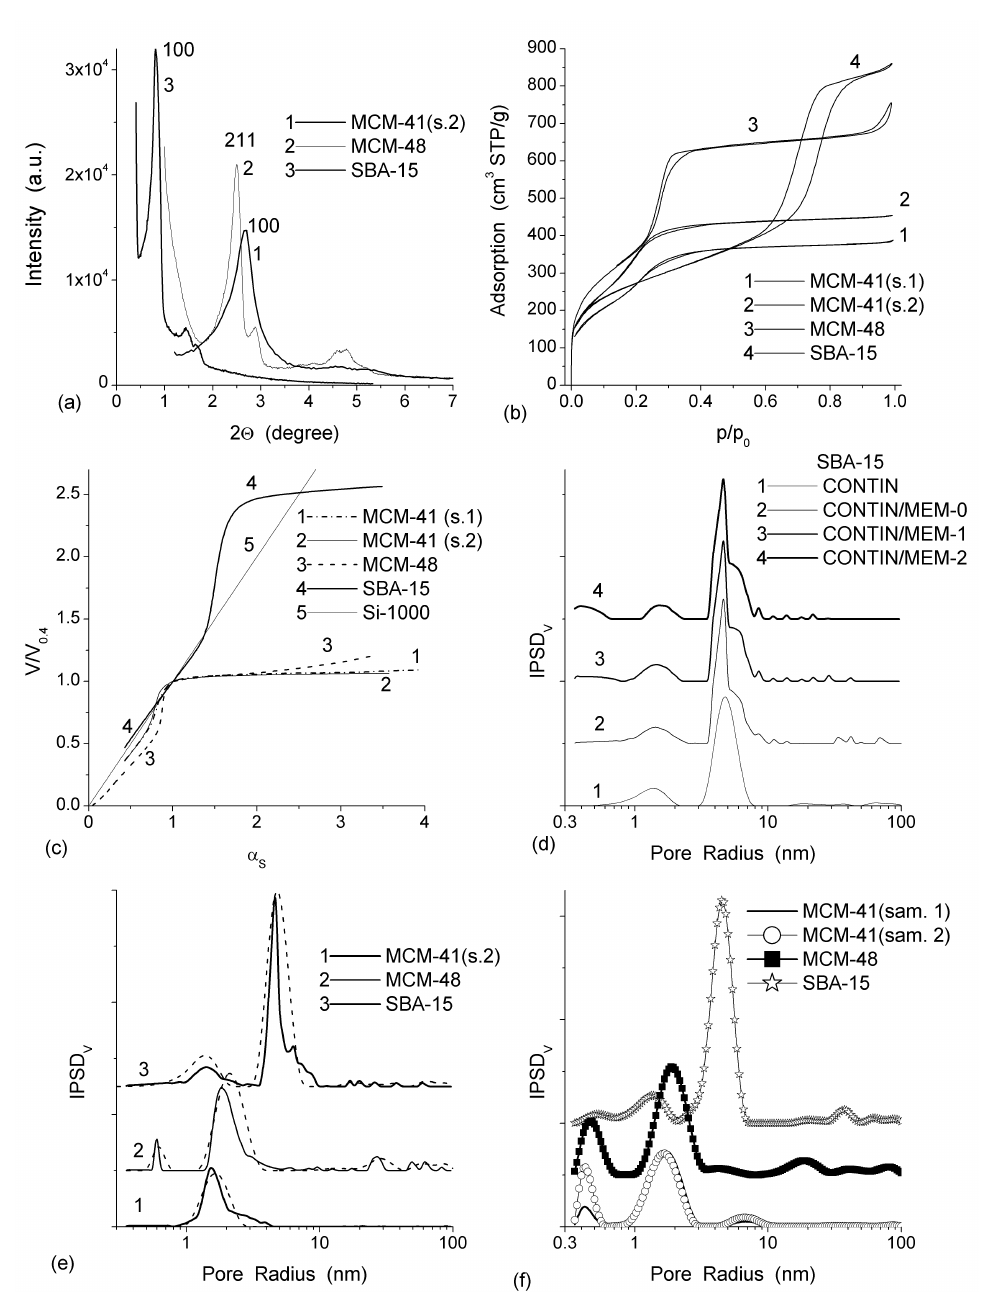
Fig. 1 (a) XRD patterns of ordered mesoporous silicas; (b) nitrogen adsorption isotherms; (c) α S plots (silica gel Si-1000 as a reference) corresponding to the nitrogen adsorption isotherms; and incremental pore size distributions for (d) SBA-15 with CONTIN and CONTIN/MEM-j and the model of cylindrical pores (d); and (e, f) MCM-41 ((e) sample 2 and (f) samples 1 and 2), MCM-48 and SBA-15 with respect of the pore volume with the model of (e) cylindrical pores (CONTIN/MEM-0 (solid line) and CONTIN (dashed line)) and (f) cylindrical pores plus voids between spherical particles (CONTIN) calculated with self-consisting regularization